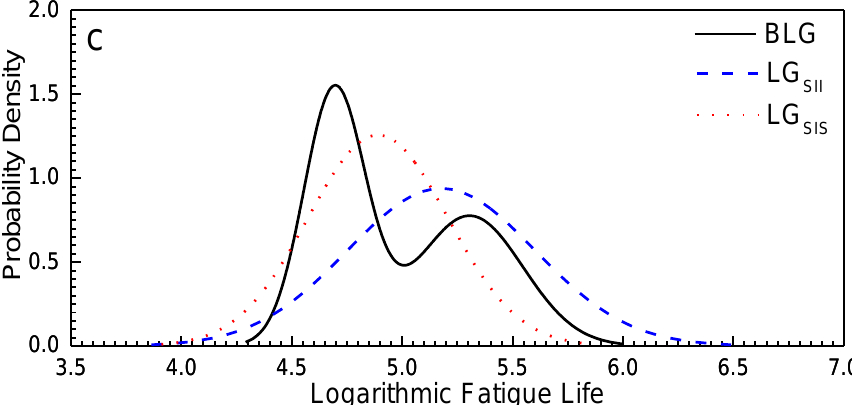
Figure 10. Comparisons of the PDFs of LG SII , LG SIS , and BLG under ( a ) 720, ( b ) 760, and ( c ) 800 MPa.